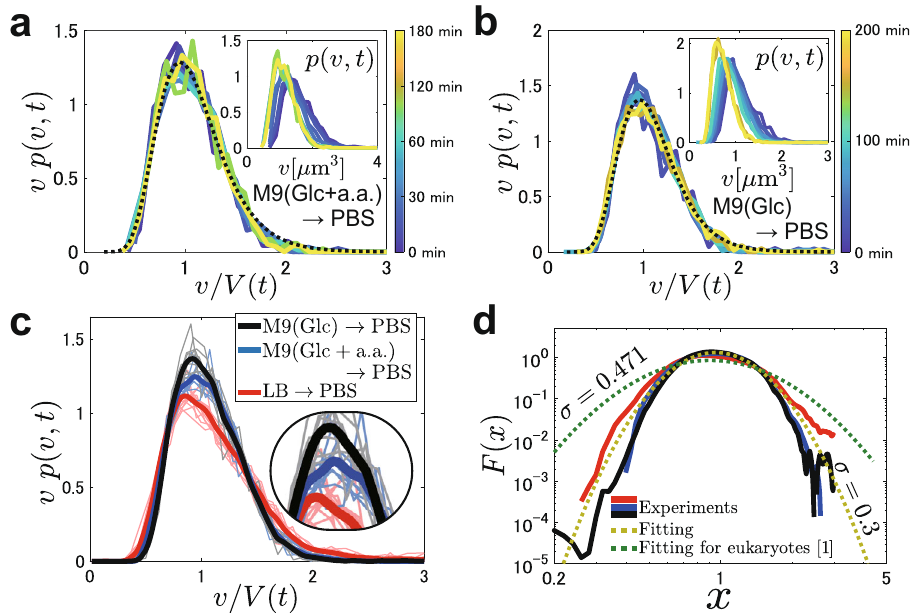
Fig. 3 Rescaled cell size distributions. a The results for M9(glucose (Glc) + amino acids (a.a.)) → PBS. The dashed line represents the fi tted log-normal distribution ( σ = 0.31(2)). The data were taken from 17 wells recorded in a single experiment. The sample size ranges from n (0) = 685 to n (180) = 1260 (see Supplementary Fig. 4). (Inset) Time evolution of the non-rescaled cell size distributions at t ¼ 0 ; 10 ; 20 ; 30 ; 40 ; 50 ; 60 ; 90 ; 120 ; 180 min. b The results for M9(glucose (Glc)) → PBS. The dashed line represents the fi tted log-normal distribution ( σ = 0.29(2)). The data were taken from 26 wells recorded in a single experiment. The sample size ranges from n (0) = 836 to n (200) = 2160 (see Supplementary Fig. 4). (Inset) Time evolution of the non- rescaled cell size distributions at t ¼ 0 ; 10 ; 20 ; 30 ; 40 ; 50 ; 60 ; 80 ; 100 ; 150 ; 200 min. c Experimental results of F ( v / V ( t )) = vp ( v , t ) for the three cases studied in this work. The raw data obtained at different times are shown by thin lines with relatively light colors, and the time-averaged data are shown by the bold lines. The time-averaged distributions (bold lines) are found to be slightly but signi fi cantly different among the three cases. The difference can also be seen in the instantaneous distributions (thin lines; see the inset for enlargement near the peak). d Fitting of the experimentally obtained F ( x ) (solid lines; time-averaged data in ( c ) are shown) to the log-normal distribution (yellow dotted line). Also shown is the fi tting result by Giometto et al. 1 for unicellular eukaryotes (green dotted line). σ is the standard deviation parameter of the log-normal distribution (see text).